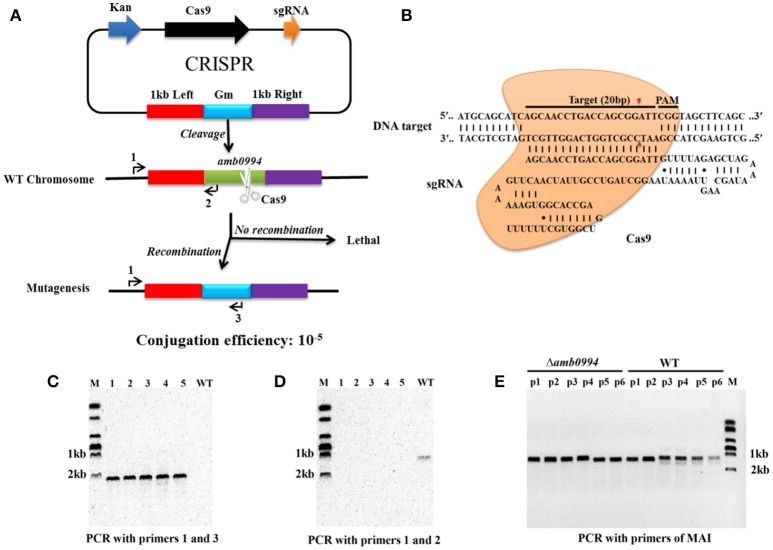
CRISPR-Cas9-assisted genome editing in M. magneticum AMB-1 cells. (A) Strategy for deletion of the amb0994 gene by CRISPR-Cas9 assisted HDR in M. magneticum AMB-1 cells. An sgRNA transcripts guide Cas9 nuclease to introduce DSBs at ends of amb0994 gene, while a codelivered editing template repairs the gap via HR. Kan is kanamycin. Gm is gentamycin. (B) Schematic of RNA-guided Cas9 nuclease uses for editing of the AMB-1 amb0994. An sgRNA consisting of 20 nt sequence (black bar) guide the Cas9 nuclease (orange) to target and cleavage the genomic DNA. Cleavage sites are indicated by red arrows for ~3 bp upstream of PAM. (C,D) PCR evaluation of amb0994 deletion from five colonies (1–5) with WT control. (E) Six fragments within MAI were amplified to evaluate the maintenance of genomic MAI during deletion.